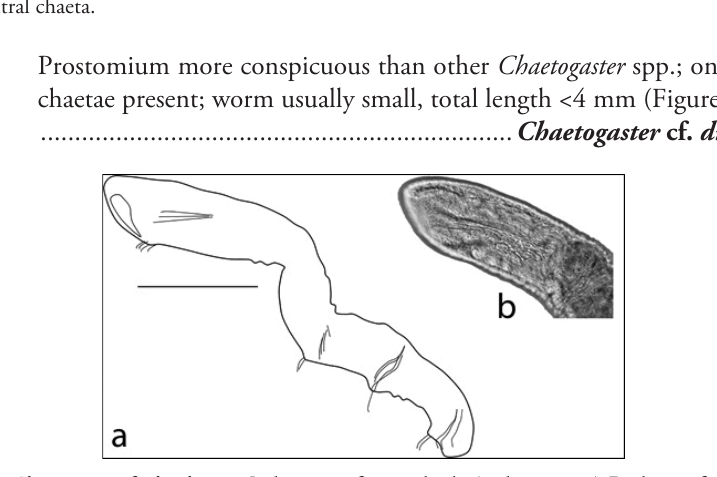
Figure 5. Chaetogaster cf. diaphanus : A drawing of entire body (scale 250 µm) B photo of anterior end showing prostomium protruding forward from mouth.